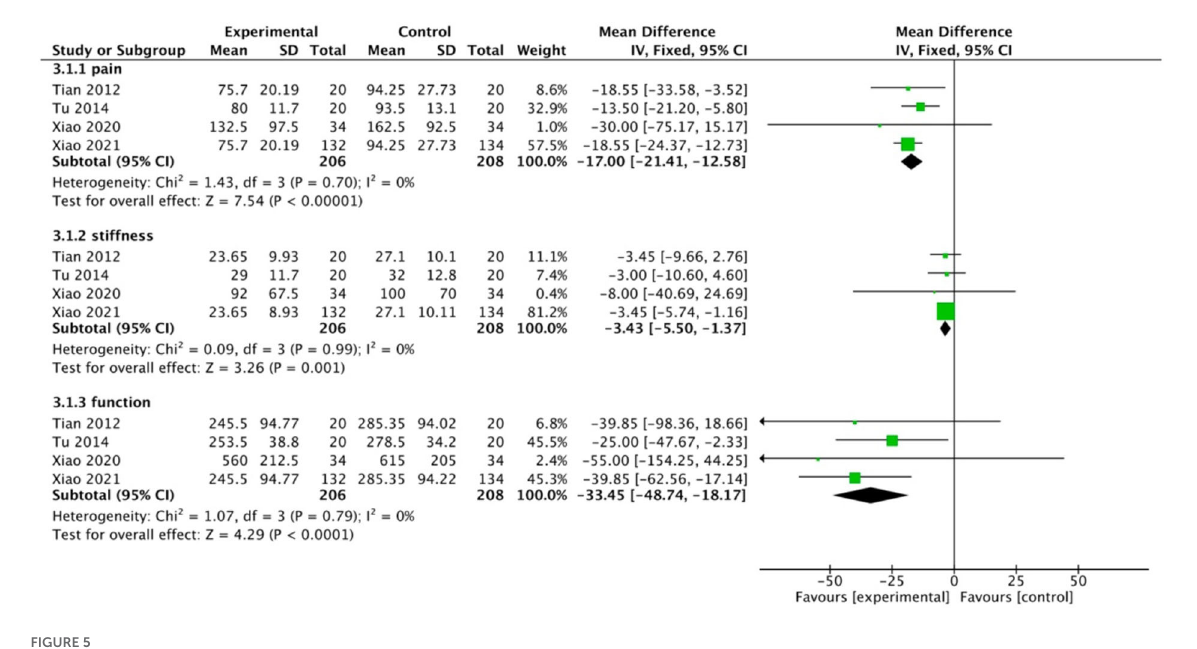
FIGURE5 WOMAC-based pain, stiffness, and functional ratings.